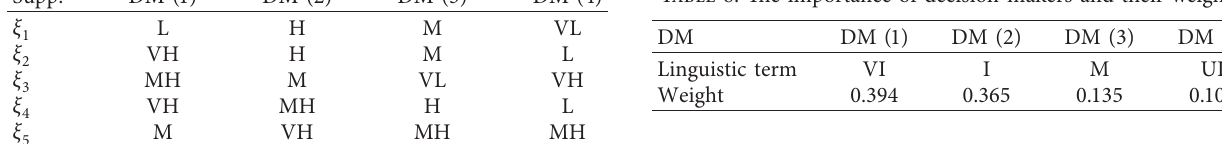
. 1 Table 8: The importance of decision-makers and their weights.